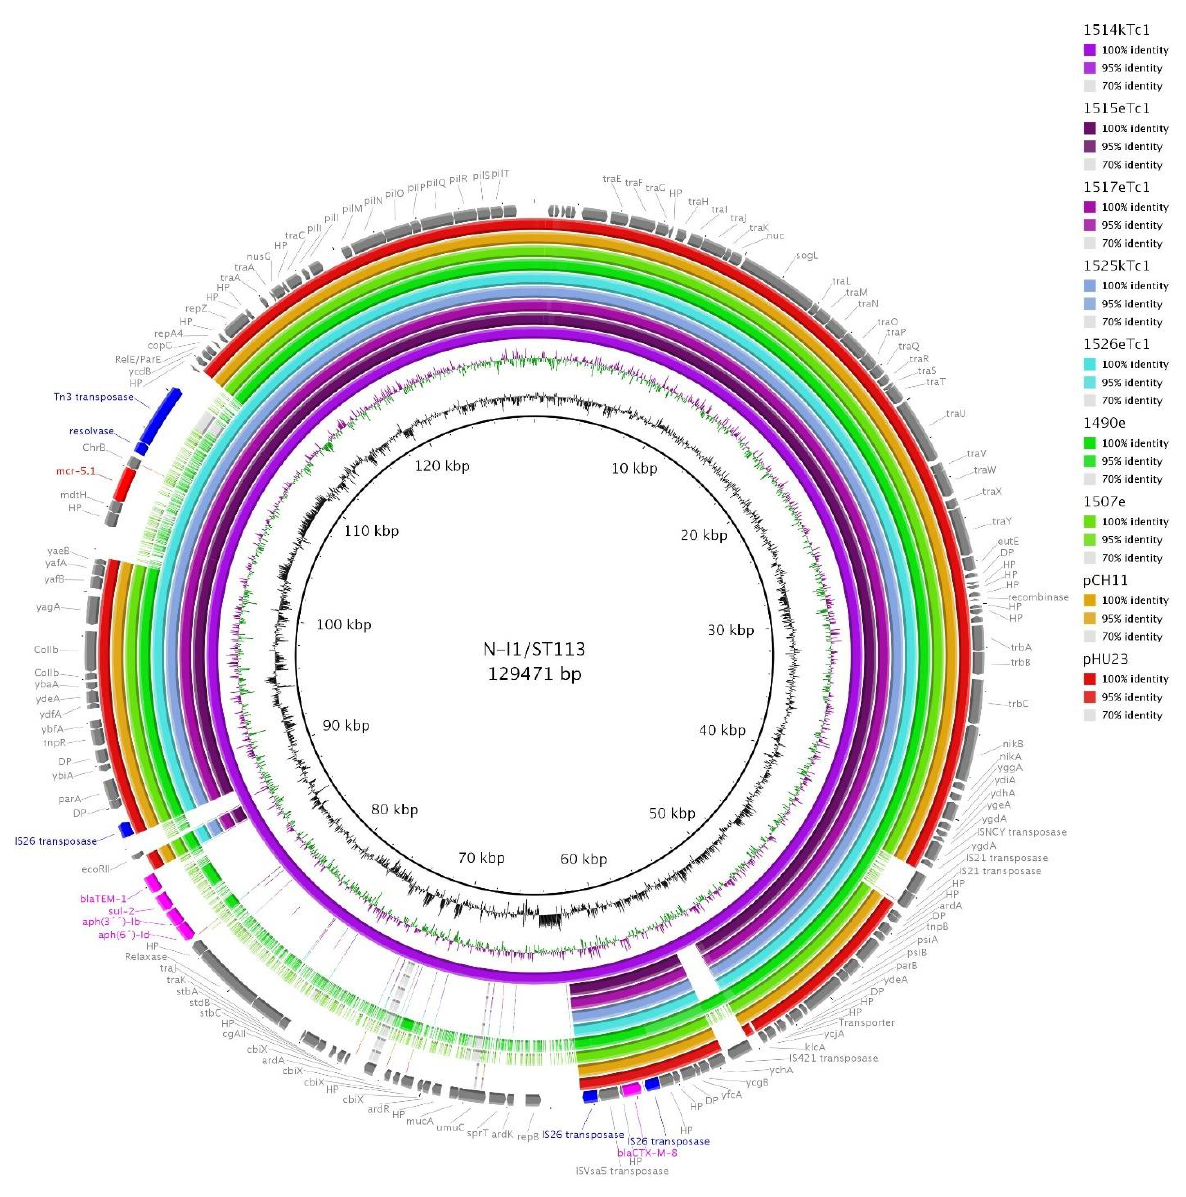
Figure 4. BRIG comparison of selected I1/ST113 plasmids. Depicted I1/ST113 plasmids came from the Paraguayan hatchery isolates (1514kTc1, 1515eTc1,1517eTc1, 1525kTc1 and 1525eTc1 using Illumina data from plasmid-DNA of a single-plasmid transconjugant Tc1), from the Brazilian hatchery (1490e and 1507e) and a previous study from Japan (pCH11 and pHU23) [5]. A reference fusion N-I1/ST113 plasmid was obtained using PacBio (GenBank accession no MW800641). Antibiotic resistance genes are depicted in fuchsia, except mcr-5.1 (red), mobile genetic elements of interest are highlighted in blue.